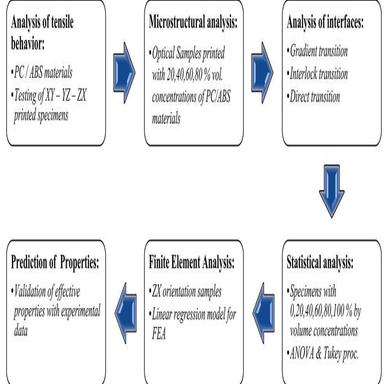
Design, fabrication and characterization workflow of FGMs produced by FFF process.